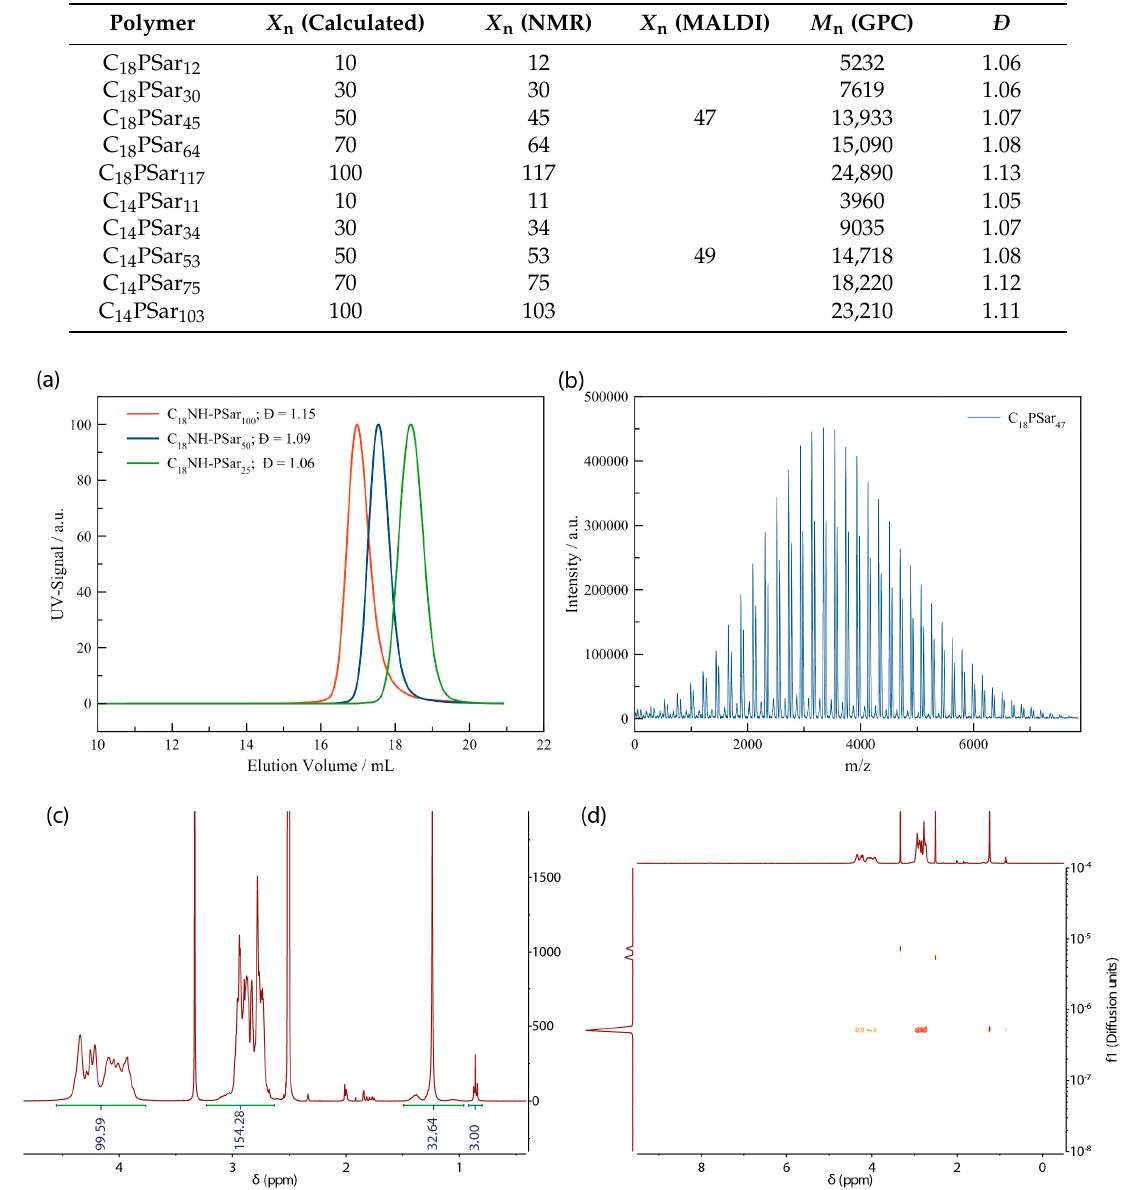
Table 1. Polymer analysis of amphiphilic PSars.